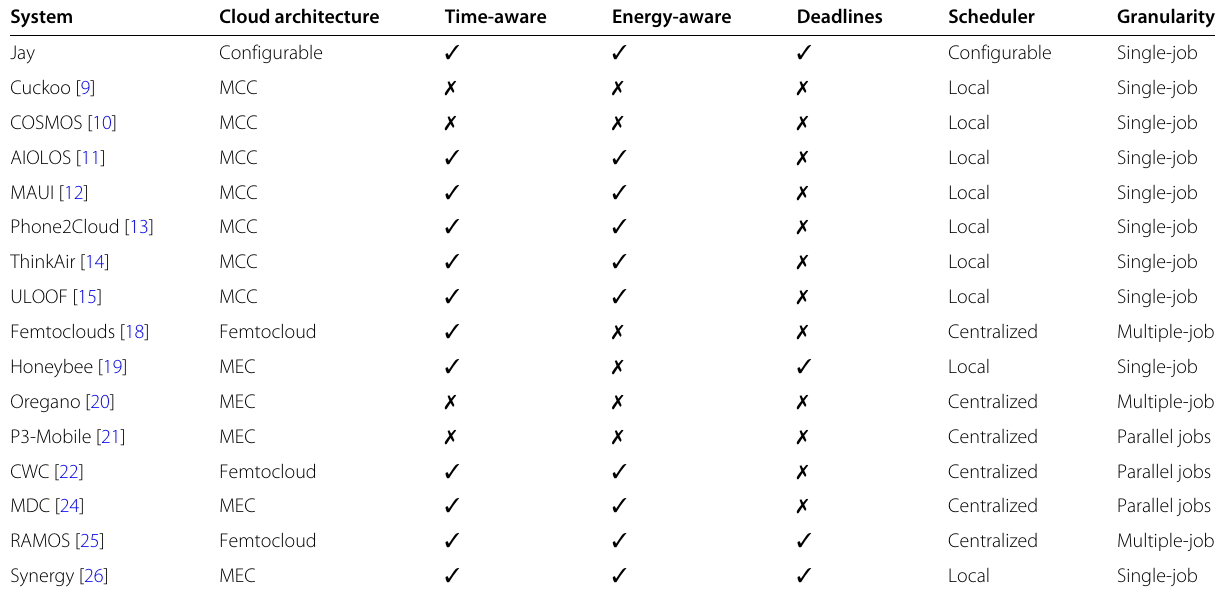
Table 1 Comparison between offloading systems